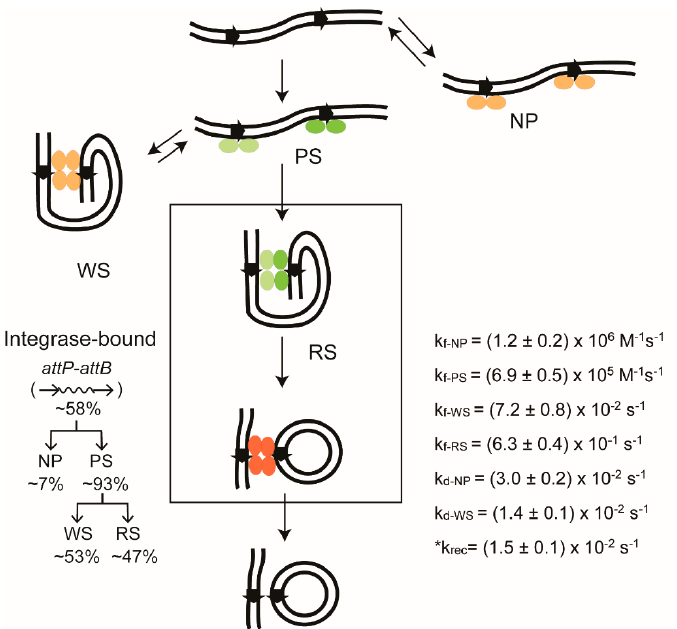
Figure 10. TPM picture of recombination by φ C31 integrase from start to finish. The diagram is arranged as in Figure 7, and depicts the reaction between head-to-tail attP–attB sites by the integrase in the absence of the RDF protein. The productive and abortive integrase–DNA complexes are named as in Figure 7. The integrase dimers in the functional reaction path are shown in green, and those external to this path are shown in pale orange. In the product synapse containing attL and attR, the dimers are shown in orange to indicate that attL–attR recombination does not occur in the absence of RDF. The relative abundance of individual complexes is indicated, and the kinetic constants for their transitions are listed. There is no Holliday junction intermediate in this reaction. The attP–attB reaction is blocked in the presence of RDF in amounts sufficient to channel the synapse quantitatively into its inactive configuration. Similar reactions schemes with kinetic parameters have been derived for inversion between head-to-head attP–attB sites promoted by the integrase, and for deletion between head-to-tail attL–attR sites promoted by integrase plus RDF. The details can be found in Fan et al. [43]. The rate constant for recombination k rec , marked by an asterisk, was derived from the inversion reaction between attP–attB sites in head-to-head